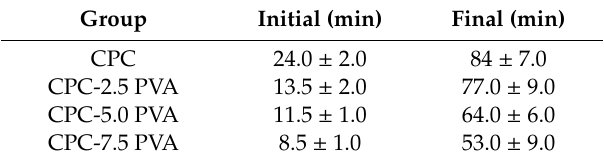
Table 1. Setting time of the cements (average ± standard deviation).